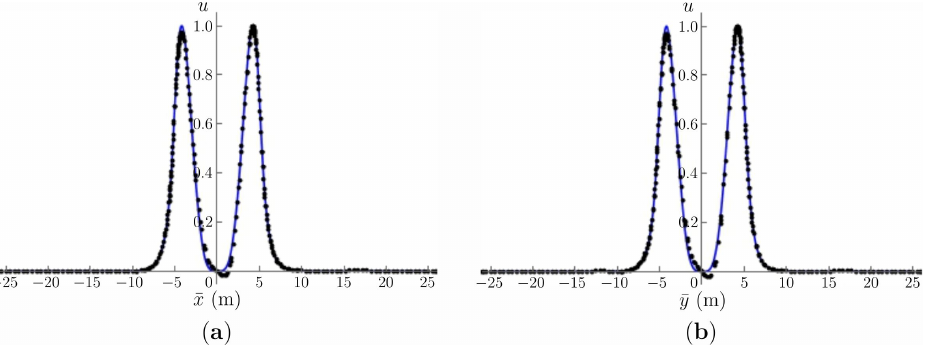
Figure 5. Same as in Figure 1, but obtained numerically with a finite element code built in Comsol Multiphysics. The mode number is ( a ) q = 4 and ( b ) q = 10. In the simulations, the side length of the plate is L = 50 m.